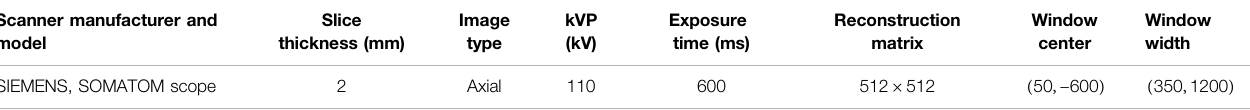
TABLE 1 | Imaging device and settings used to acquire the in-house